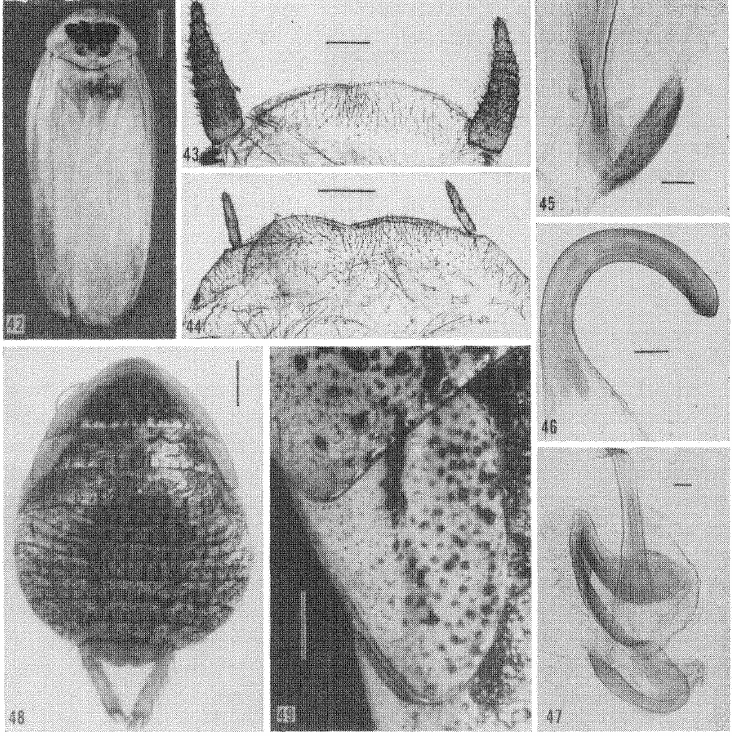
Figures 42-49. Calolamra candidula. 42-46. 8 (1 QM), holotype, Bellevue, Q. 42. Adult. 43-44. Supra-anal plate and hypandrium..45-47. Genitalia. 48-49. ? (116 MCZ), Cairns, Q. 48. Female. 49. Tegmen of female shown in figure 48. Scale: Fig. 42 4 ram; Figs. 43-44 0.5 ram; Figs. 45-47 0.1 mm; Fig. 48 ram; Fig. 49